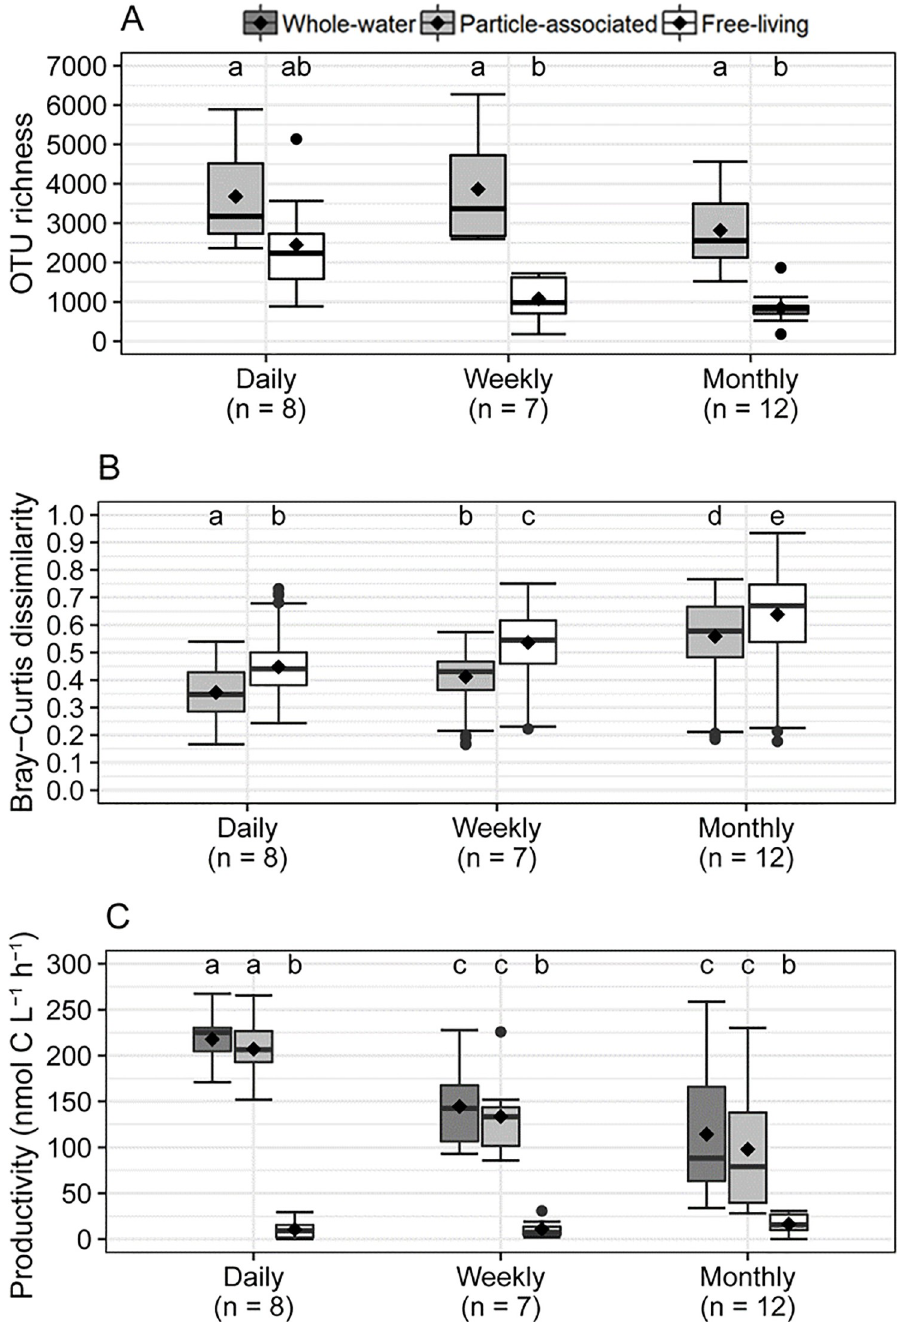
Fig 4. Boxplots showing variance in bacterial assemblage (A) OTU richness (B) Bray–Curtis dissimilarity, and (C) production ( 3 H-leucine) among sampling timescales. Boxes show medians (dark lines), averages (diamonds), and inter-quartile ranges. Whiskers indicate data within 3X inter-quartile ranges, and points are outliers. Letter(s) above boxes indicate the groups of samples that are significantly different in their medians (Mood’s median tests: p < 0.001). Sample sizes are presented for each